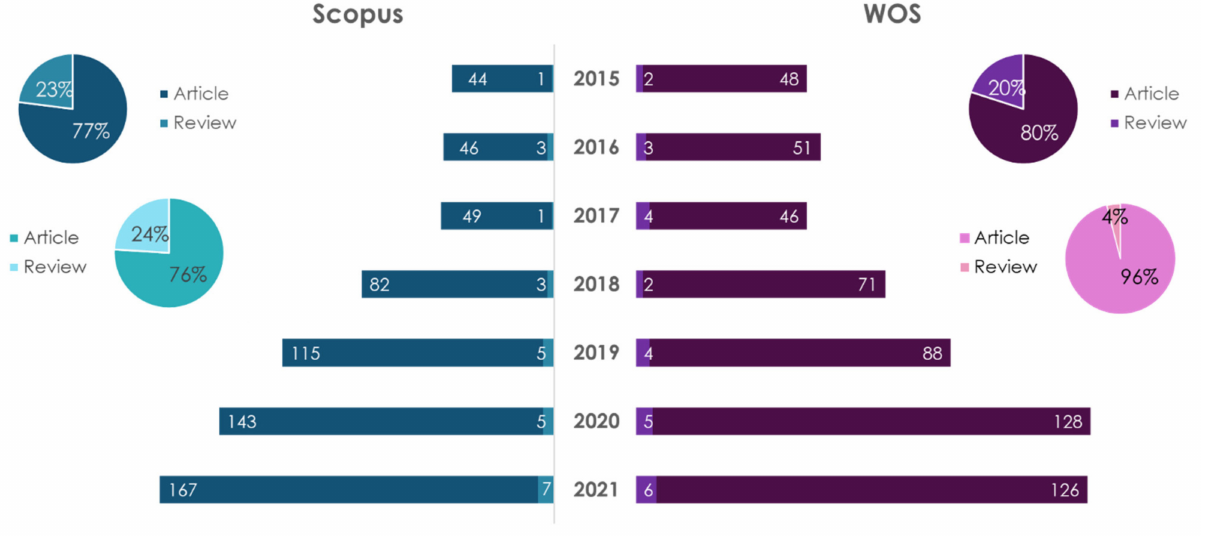
Figure 11. Statistical results of the search in Scopus/WOS databases by the keywords “DASH-diet” (dark color) and “DASH-diet and atherosclerosis” (light